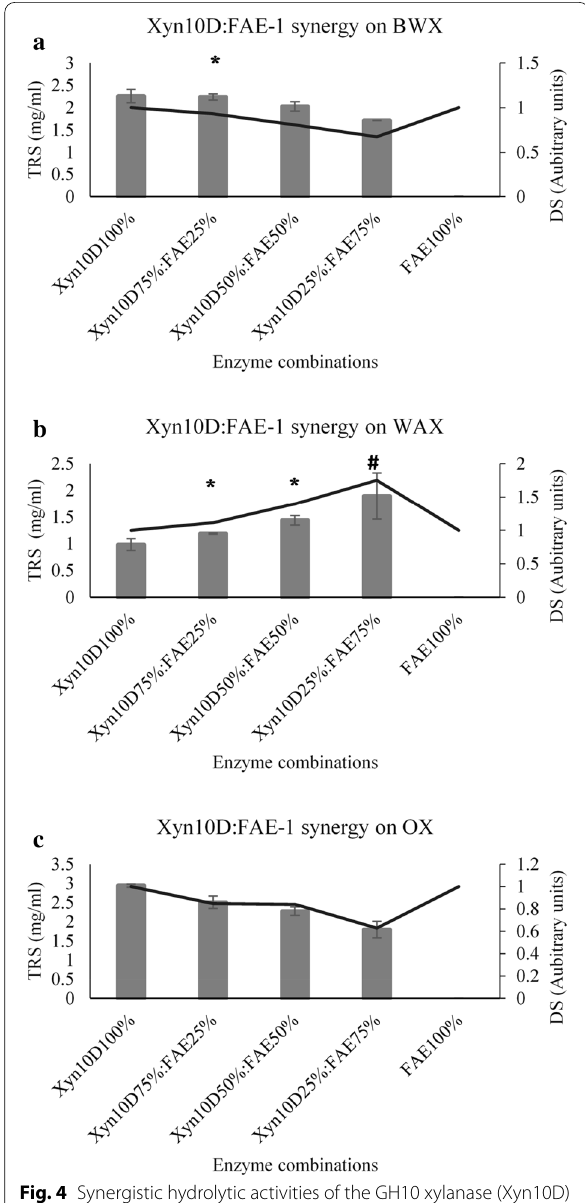
Fig. 4 Synergistic hydrolytic activities of the GH10 xylanase (Xyn10D) and feruloyl esterase (FAE-1) on beechwood xylan ( a ), insoluble wheat arabinoxylan ( b ) and oat spelt xylan ( c ). The TRS represent the amount of released total reducing sugars from xylan and DS represents the degree of synergy formed between two enzymes. ANOVA analysis indicated the improvement of reducing sugar release by the enzyme combinations compared to lone enzyme protein loading, keys: *(p value < 0.05) and #(p value < 0.01). Values are represented as mean values SD (n ± =